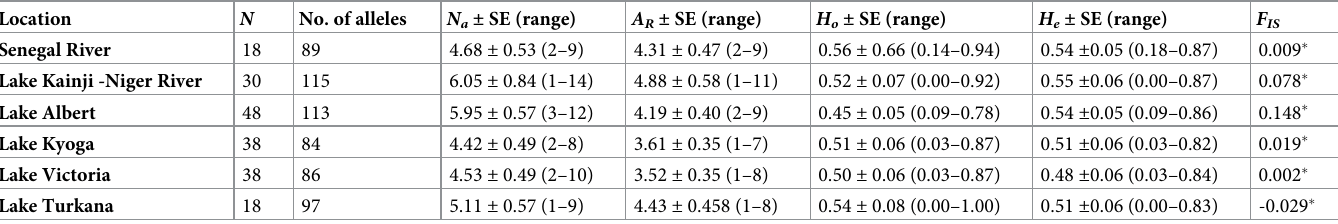
Values for microsatellite statistics are means over all loci (range) for each location: N , sample size, N heterozygosity, H e , mean expected heterozygosity and F IS , inbreeding coefficient. (cid:3) Significant F IS values at P < 0.05.